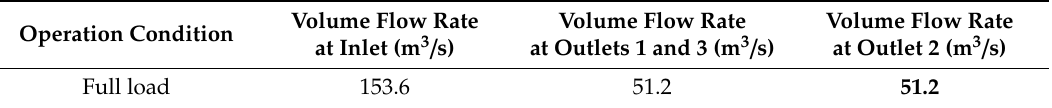
Table 3. Volumetric flow rates of full load operation